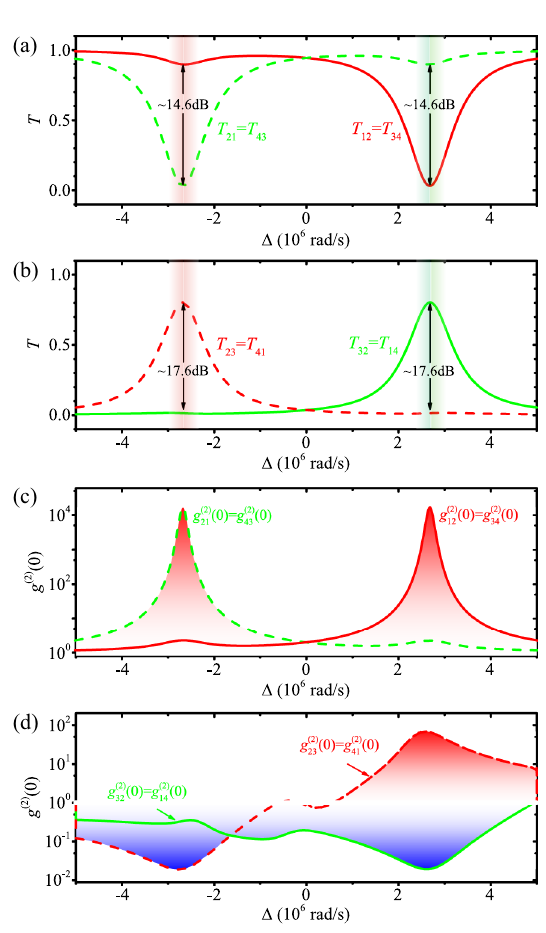
Figure 4. (Color online) ( a ) and ( b ) the port-to-port transmission spectra versus the detuning (cid:31) with back scattering of J = 2 κ ; ( c ) and ( d ) the equal-time second-order correlation function of the port-to-port transmission photons versus the detuning (cid:31) with back scattering of J = 2 κ